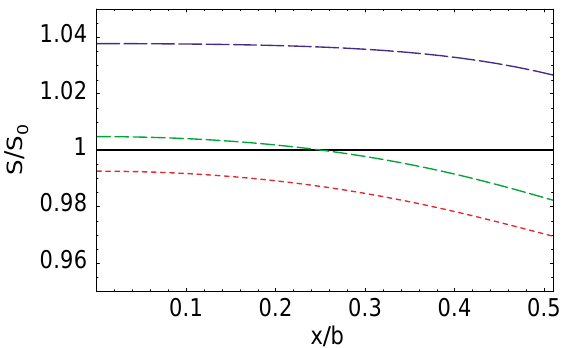
FIG. 5. (Color) Relative magnitude of beam-size corrections in a circular chamber with s x (cid:2) b (cid:1) 0.1 , s y (cid:2) b (cid:1) 0.2 for three ver- tical beam offsets y (cid:2) b (cid:1) 0, 1 (cid:2) 4, 1 (cid:2) 2 (short-dashed line, dashed line, long-dashed line, respectively). Here “1” corresponds to a pencil beam case, i.e., to one of the three curves in Fig. 2 for the corresponding beam vertical